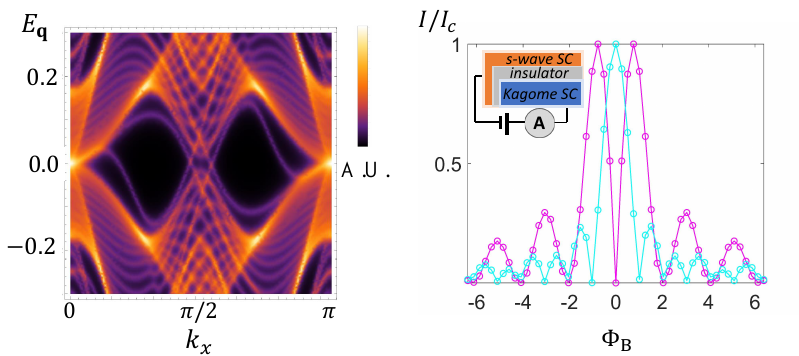
Figure 6: Left panel: Spectral function (relevant to ARPES data) of case (i) | Φ | = 0.3, | ∆ | = 0.1. Right panel: The Fraunhofer pattern on the conner Joseph- ασ α son junction for case (i) (purple curve), case (iv) (cyan curve) in the presence of (in-plane) magnetic flux Φ B